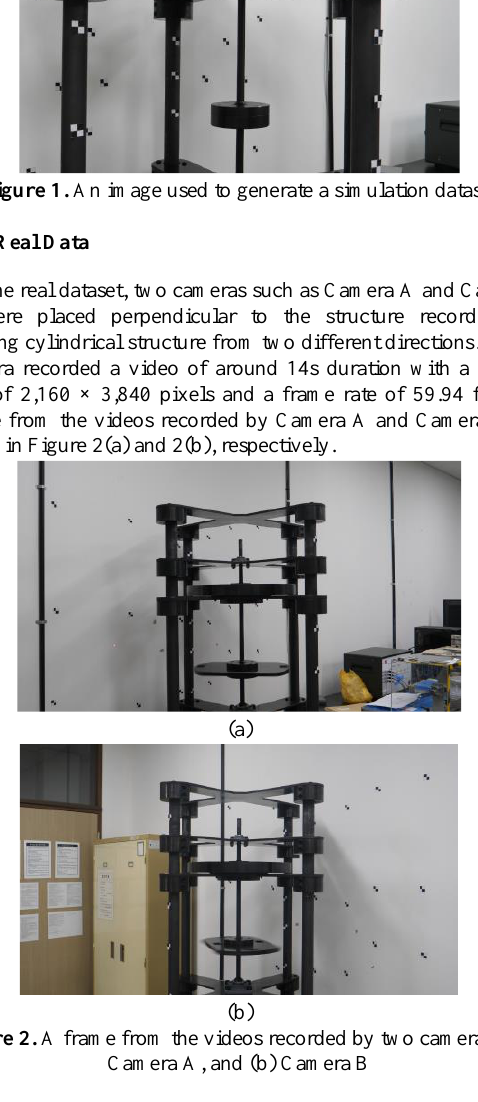
Figure 3. A close-up view of the ROI selected for vibration measurement